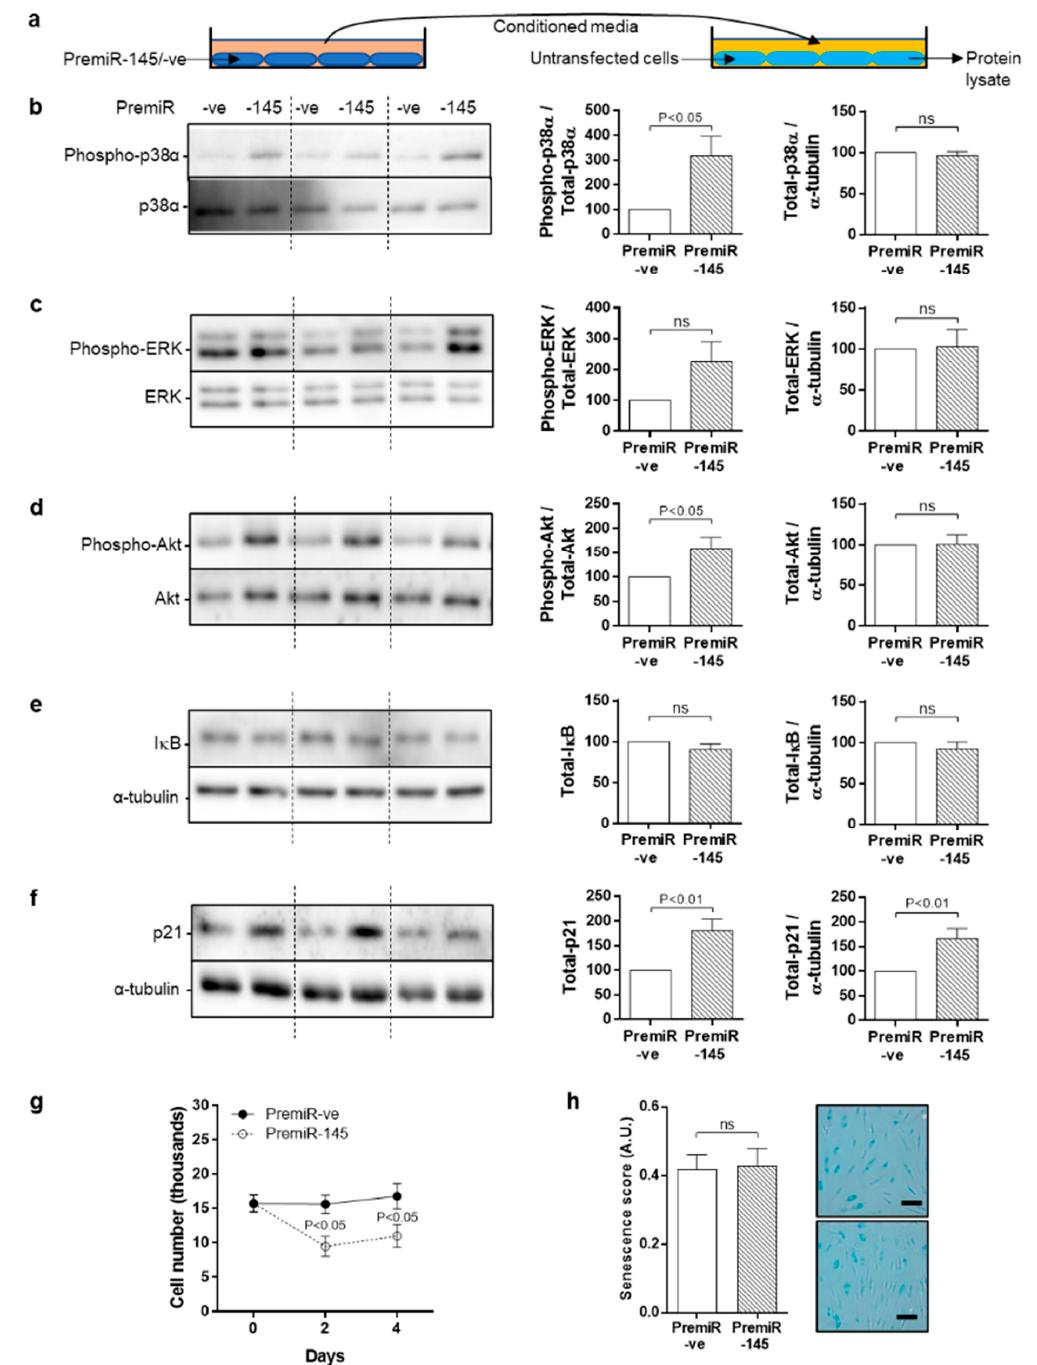
Figure 7. Conditioned medium from miRNA-145 overexpressing SMC induces a bystander effect in naive cells. ( a ) Cells were serum-starved for 72 h prior to exposure to conditioned (0.4% FCS) medium harvested from cells transfected with premiRNA-145 or premiRNA -ve for 96 h. Protein lysates were immunoblotted for ( b ) p38, ( c ) ERK, ( d ) Akt (all expression and phosphorylation), ( e ) I κ B, ( f ) p21 expression. Phosphorylation of proteins was measured against expression of the same protein, whereas changes in expression only were measured against α -tubulin as a loading control ( n = 6–9). ( g ) Cells were serum starved for 72hrs prior to exposure to conditioned (0.4% FCS) medium harvested from cells transfected with premiRNA-145 or premiRNA -ve for 96 h. Cell counts were performed at 48 and 96h post exposure to determine cell number or ( h ) were fixed and stained for presence of SA- β -galactosidase staining (scale bar = 100 µ m; n =